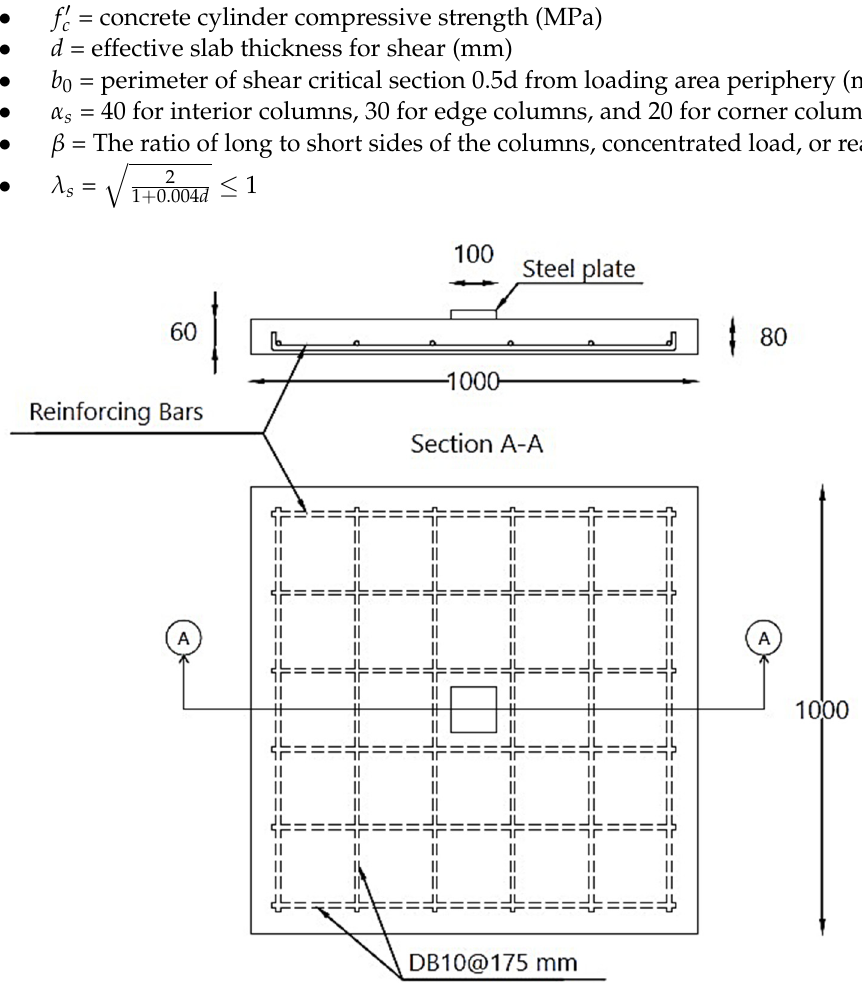
Figure 3. Typical layout of flexural reinforcement (units: mm).